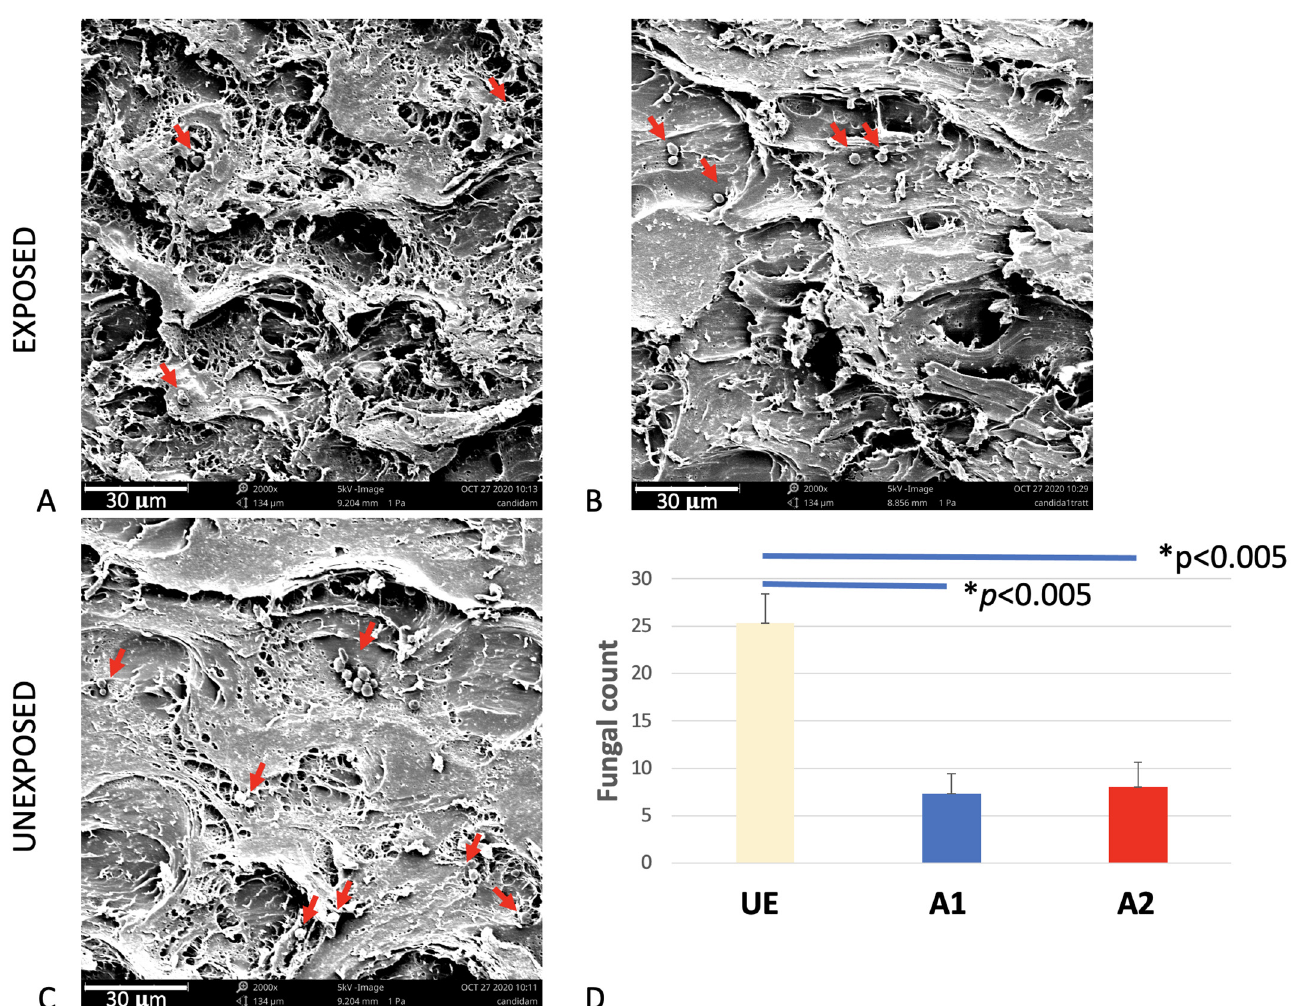
Figure 3. Candida albicans adherence on polyacrylic resin discs. ( A ) Yeasts exposed to a double antibacterial treatment. ( B ) Yeasts exposed to a single antibacterial program. ( C ) Unexposed yeasts. ( D ) Average cell count on SEM scans of area of 135 µm 2 . A1: one complete session of the antibacterial protocol with CMFs. A2: two complete sessions of the antibacterial protocol with CMFs. * p -value < 0.05. Red arrows show the Candida cells.